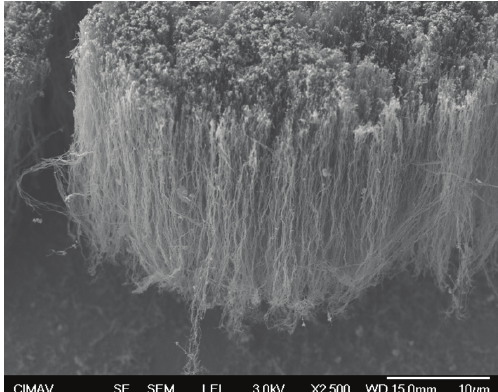
Figure 9: Well-aligned forest of carbon nanotubes synthesized to 900 ◦ C for the upstream zone.